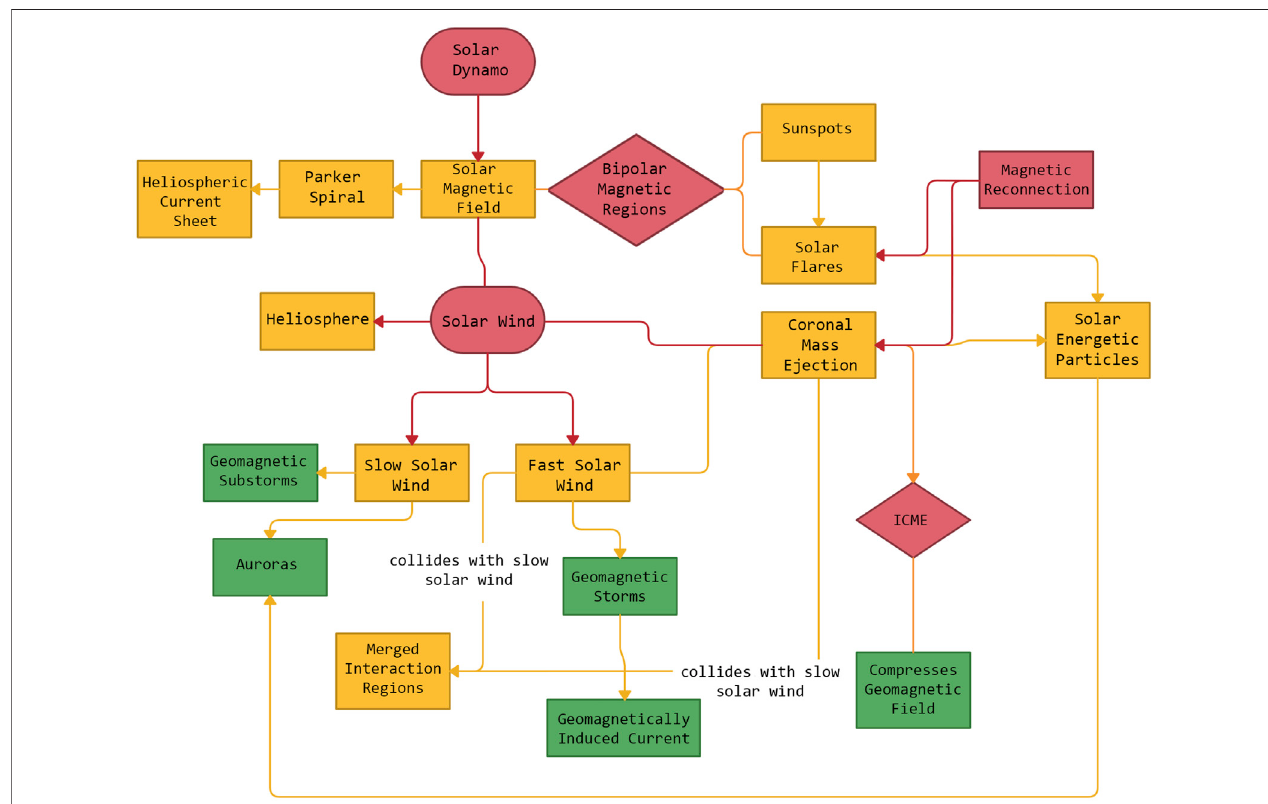
FIGURE 14 | Flow chart depicting the interconnected nature of the space weather system with connections between various space weather phenomena and structures in the solar system covered by this review paper.